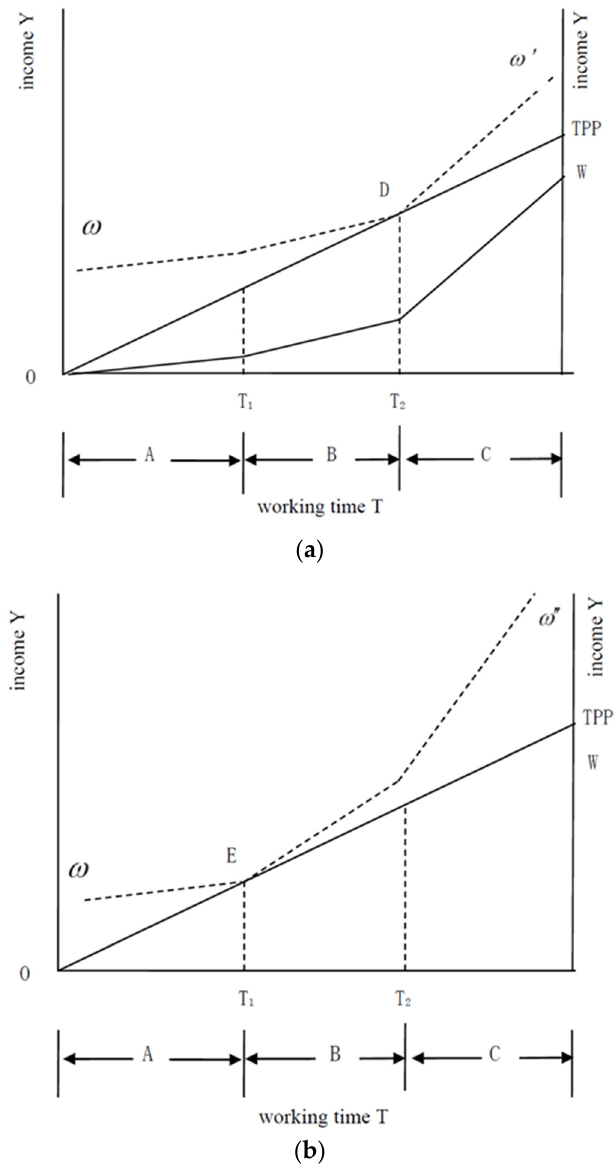
Figure 5. ( a ) Influence of household labor allocation on cultivated land abandonment ( w a < MPP, w b < MPP, w c > MPP). ( b ) Influence of household labor allocation on cultivated land abandonment ( w a < MPP, w b > MPP, w c > MPP).